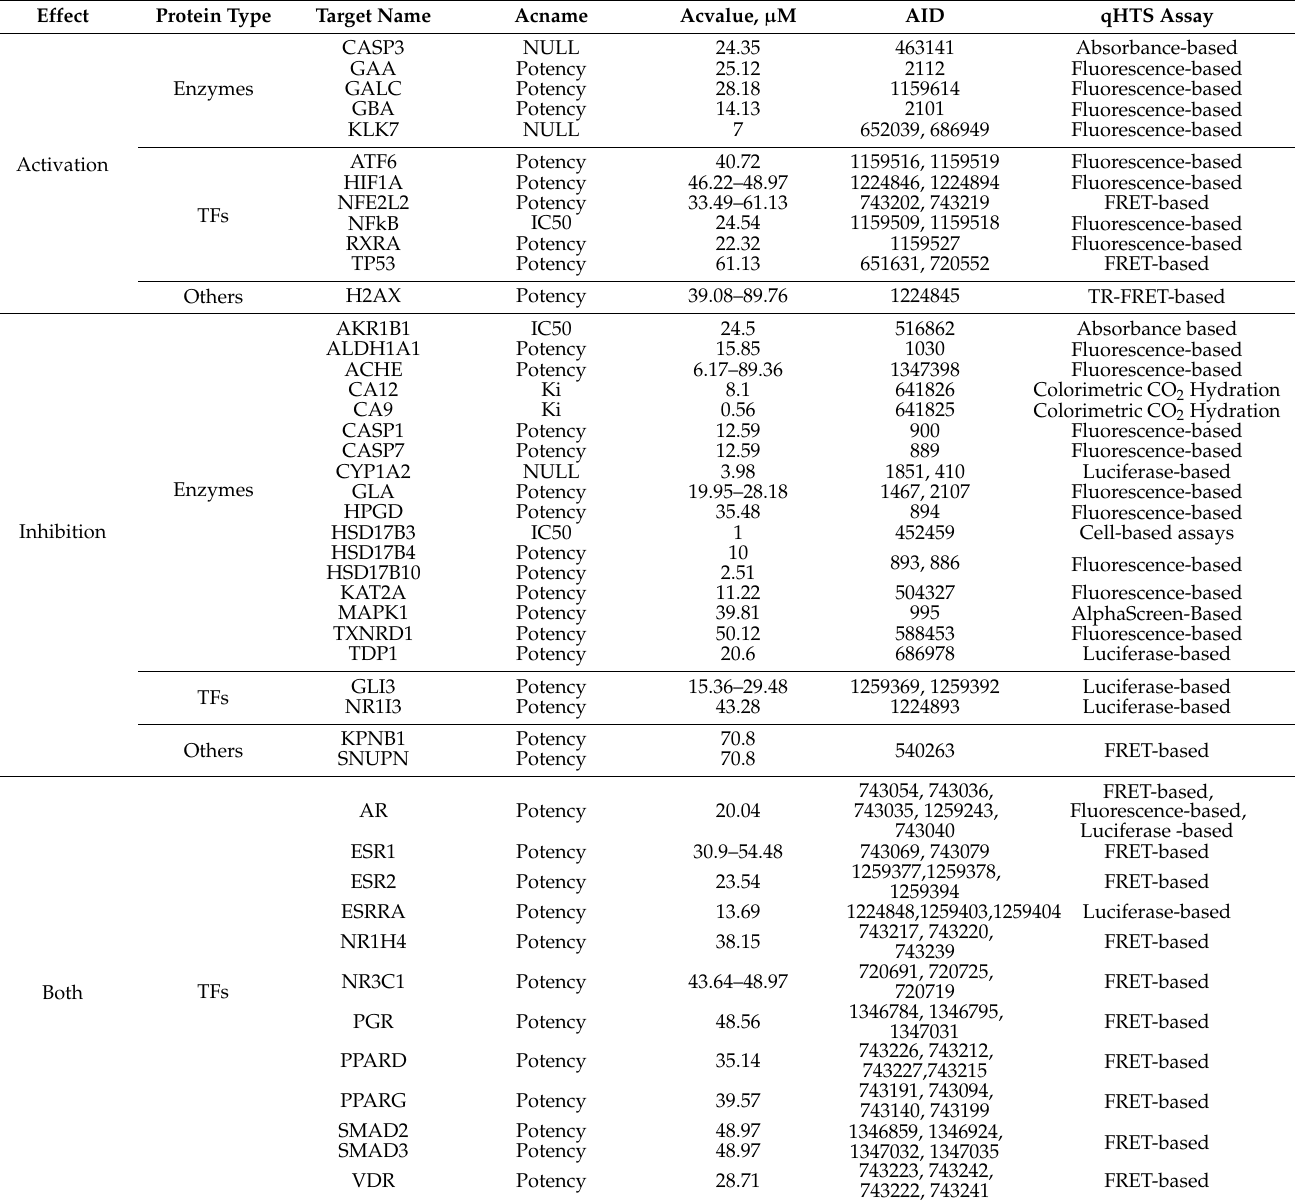
Table 2. 4MU active concentration and effect on target protein